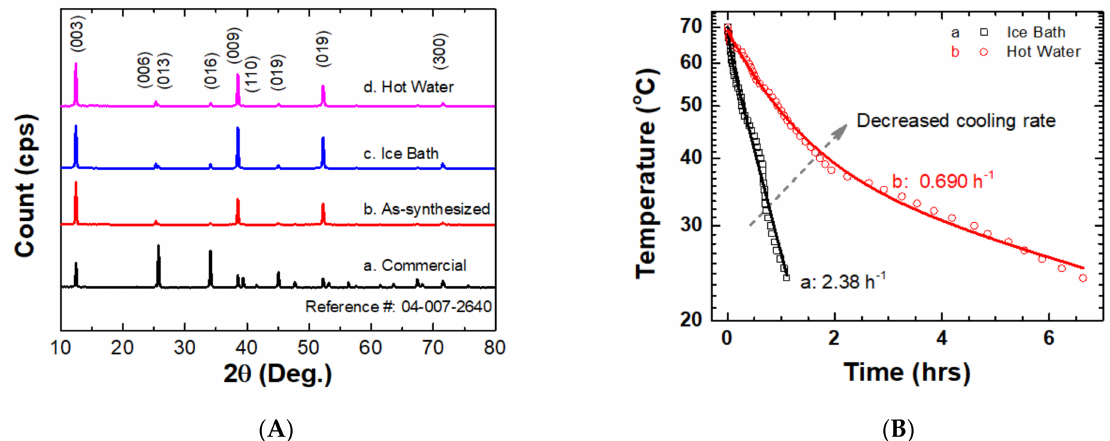
Figure 1. ( A ) XRD patterns of various PbI 2 a : commercially available, called here “Commercial”, b : as-synthesized, without recrystallization, called here “As-synthesized”, c : from as-synthesized PbI 2 , following the recrystallization process with rapid cooling in an ice bath, called here “Ice Bath”, d : from as-synthesized PbI 2 , following the recrystallization process with slower cooling in a bath containing 70 ◦ C warm water, called here “Hot Water”. ( B ) Rapid and slow cooling rate of PbI 2 containing solutions in the two crystallization processes (Hot Water and Ice Bath), following the “Golden Rain” procedure